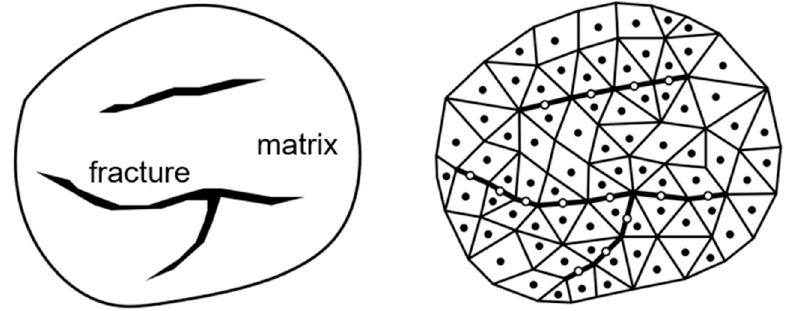
Figure 2. Schematic of a typical fractured media ( left ); the unstructured grid ( right ).